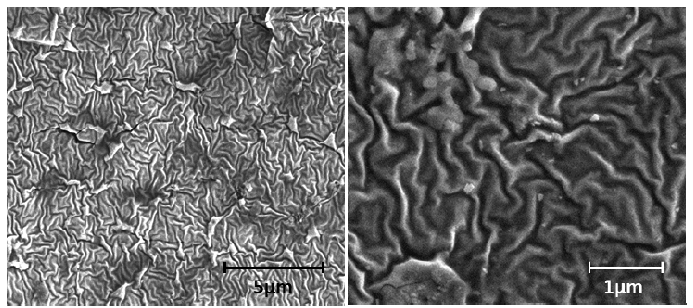
Figure 2. SEM image of PLA/25 nm WO x at different magnifications.